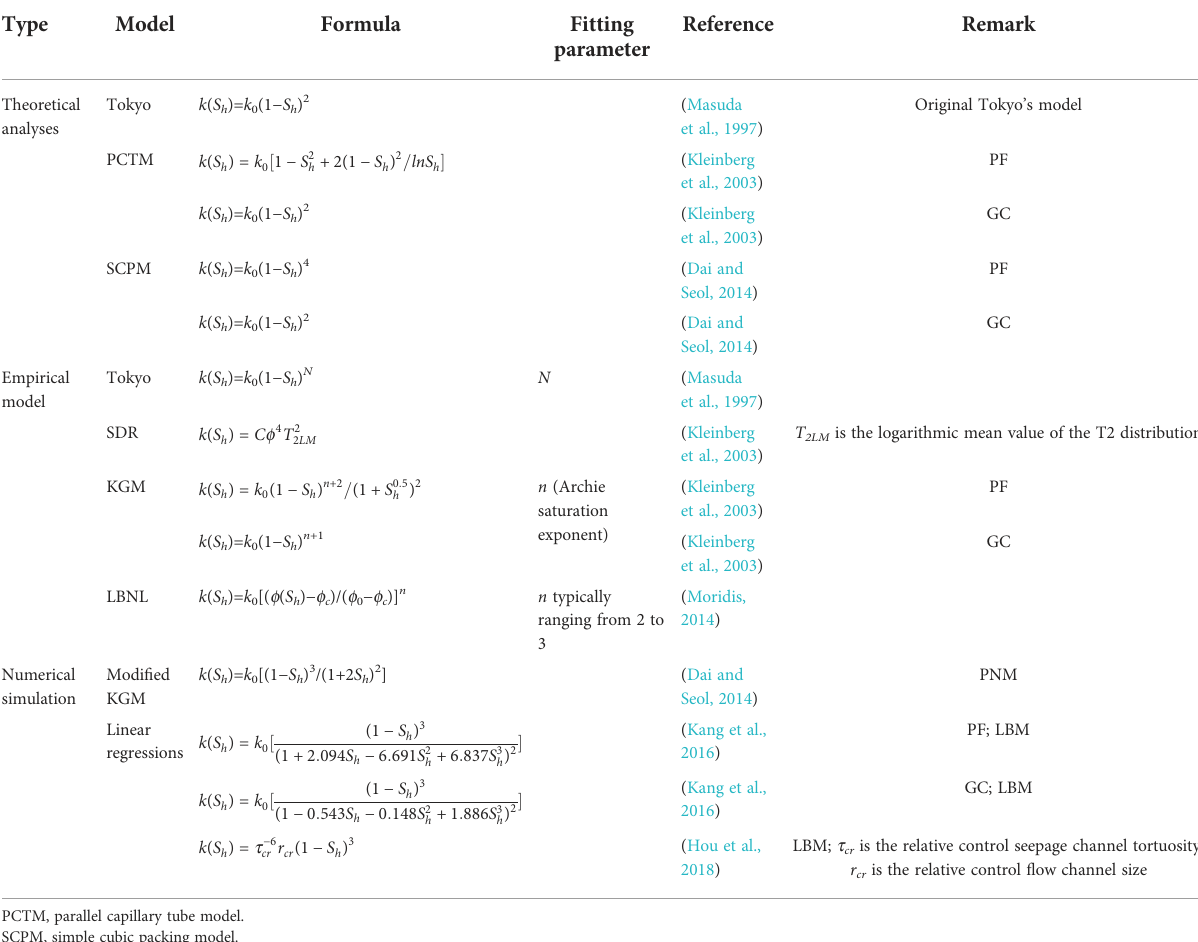
TABLE 1 Prediction models for water permeability in the presence of gas